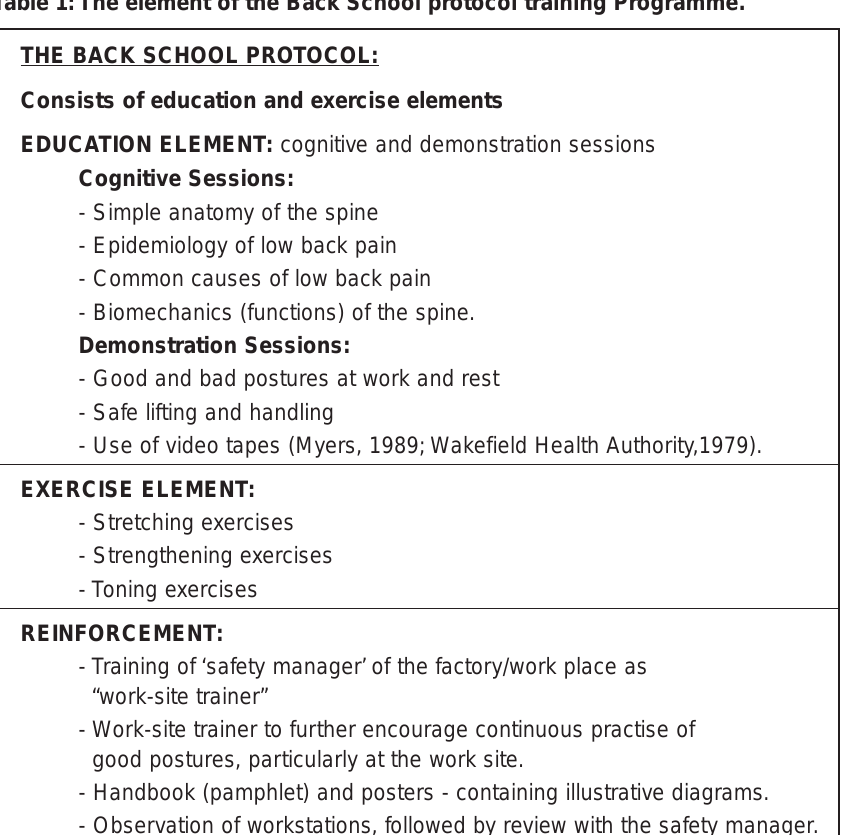
Table 1:The element of the Back School protocol training